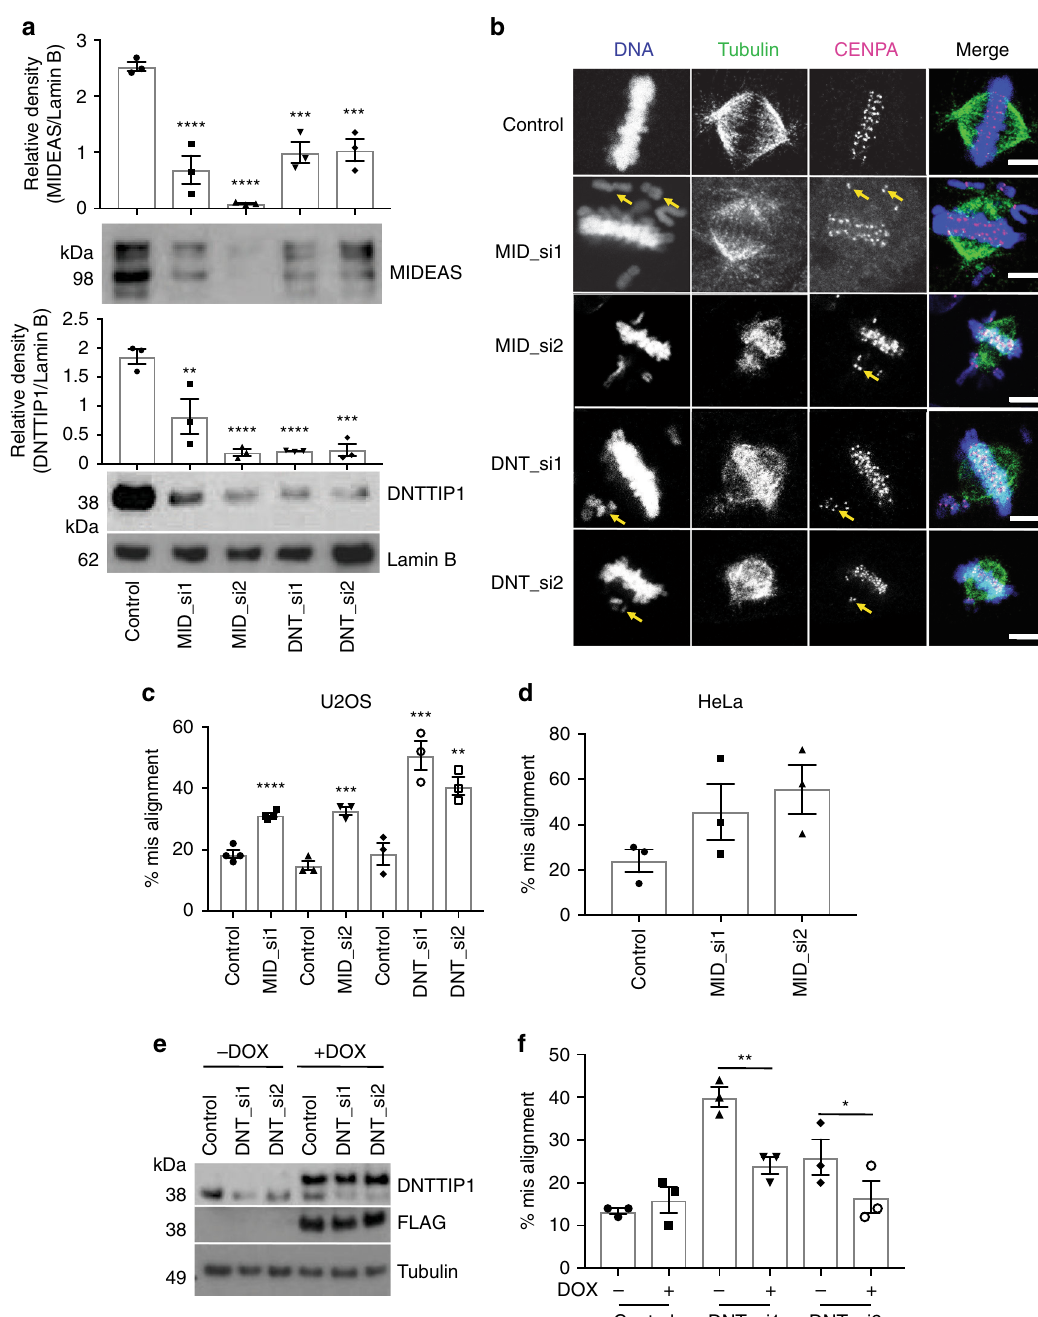
Fig. 2 MiDAC protein co-dependency and role in chromosome alignment. a Western blot for MIDEAS (top) and DNTTIP1 (bottom) following treatment of U2OS cells with siRNA for 72 h targeting MIDEAS or DNTTIP1. Blots shown are representative. LaminB was detected in parallel from the same lysate sample, and was used as a reference for normalisation (mean± s.e.m., n = 3 independent experiments, ** P = 0.0029, *** P < 0.001 ( P = 0.0003 for control versus DNT_si1, 0.0004 for control versus DNT_si2), **** P < 0.0001, one-way ANOVA with Dunnett ’ s post hoc test). b Confocal images representative of normal and misaligned chromosomes. U2OS cells were treated with siRNA as in ( a ) before fi xation with PFA and staining for α -tubulin (green), CENPA (magenta). DNA (blue) was visualised with Hoechst 33258 (scale bars: 5 μ m). c Quanti fi cation of metaphase cells with misaligned chromosomes in U2OS cells after siRNA treatment shown as percent misaligned (mean ± s.e.m, n = 3 MID_si2, DNT_si1, DNT_si2, n = 4 MID_si1, (50 metaphase cells counted over 3/4 independent experiments), *** P < 0.001 ( P = 0.0008 for control versus MID_si1, 0.0003 for control versus MID_si2), **** P < 0.0001, one-way ANOVA with Holm – Sidak post hoc test). d Quanti fi cation of metaphase cells with misaligned chromosomes in HeLa cells after MIDEAS siRNA treatment shown as percent misaligned (mean ± s.e.m., n = 3 (50 metaphase cells counted over 3 independent experiments). e Western blot using nuclear proteins isolated from stable, DOX inducible, siRNA-resistant FLAG-DNTTIP1 U2OS cell line showing DOX induces FLAG-DNTTIP1. f Quanti fi cation of metaphase cells with misaligned chromosomes in U2OS cells after siRNA treatment and induction of siRNA-resistant FLAG-DNTTIP1 with DOX (mean ± s.e.m., n = 3 (50 metaphase cells counted over three individual experiments), * P = 0.0416, ** P = 0.0041, one-way ANOVA with Holm – Sidak post hoc test). Source data are provided as a Source data fi